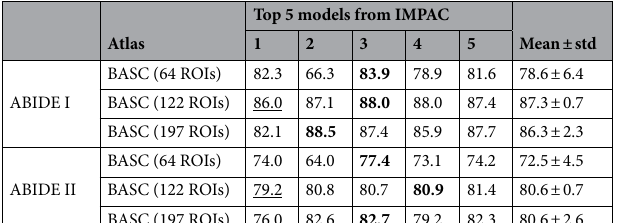
Top 5 models from